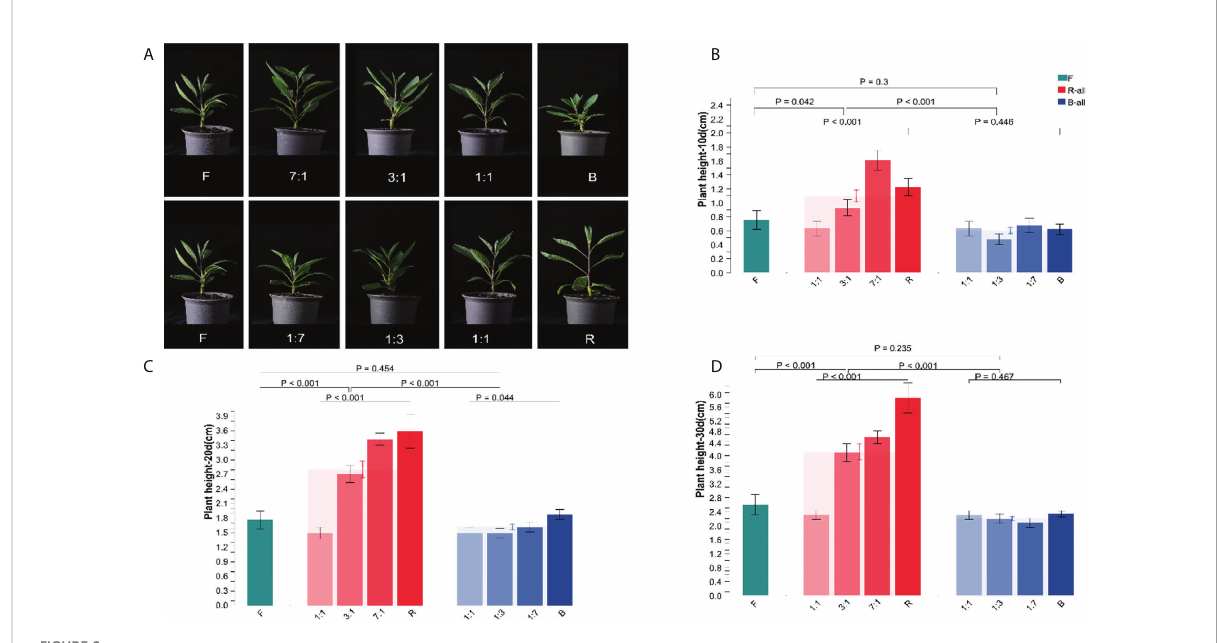
FIGURE 2 Effect of different light conditions on the height of Pepino seedlings. (A) the seedling phenotype of Pepino under different light treatments; (B) seedling height of Pepino under different light treatments for 10 d; (C) seedling height of Pepino under different light treatments for 20 d; (D) seedling height of Pepino under different light treatments for 30